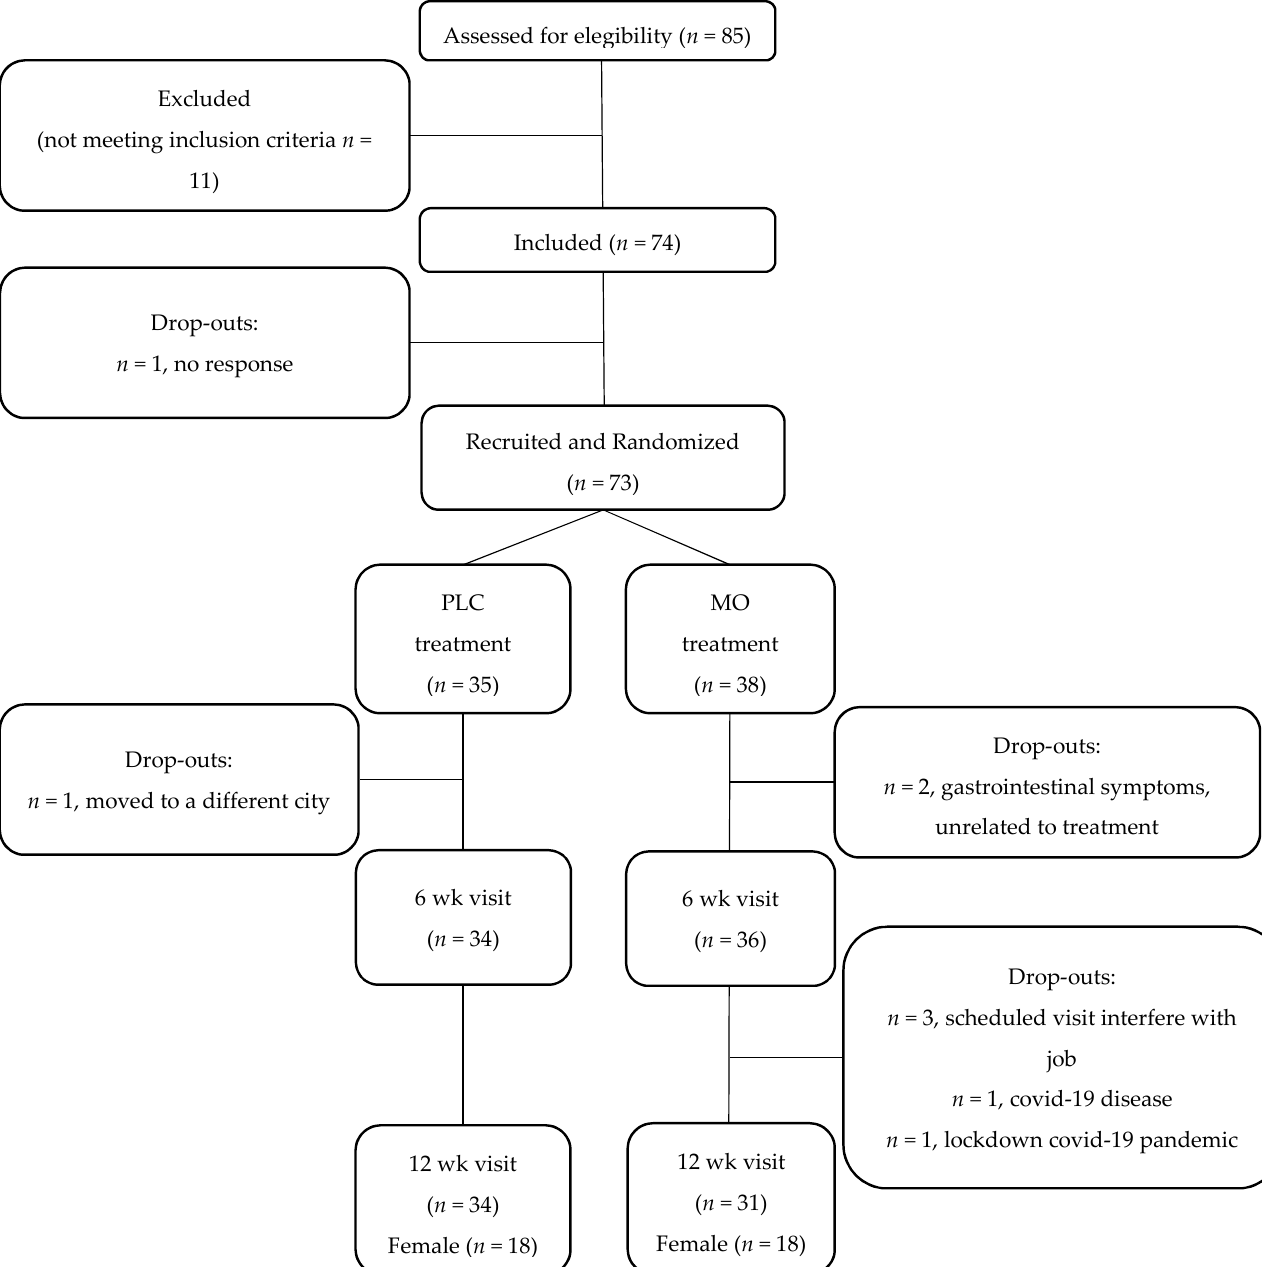
Figure 1. Flow chart of study subjects. PLC, Placebo; MO, Moringa oleifera ; wk, weeks.